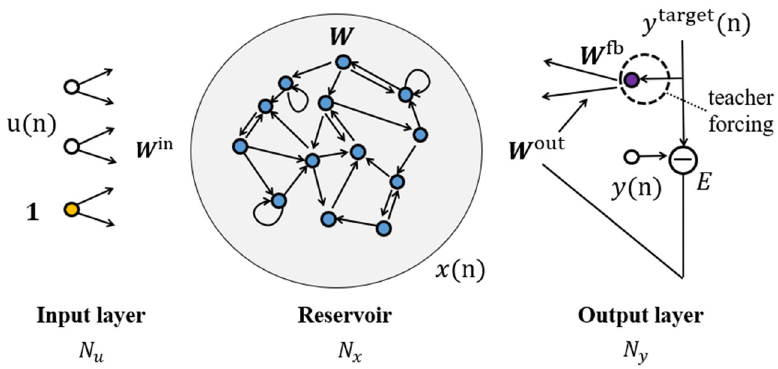
Figure 1. The architecture of an echo state network.